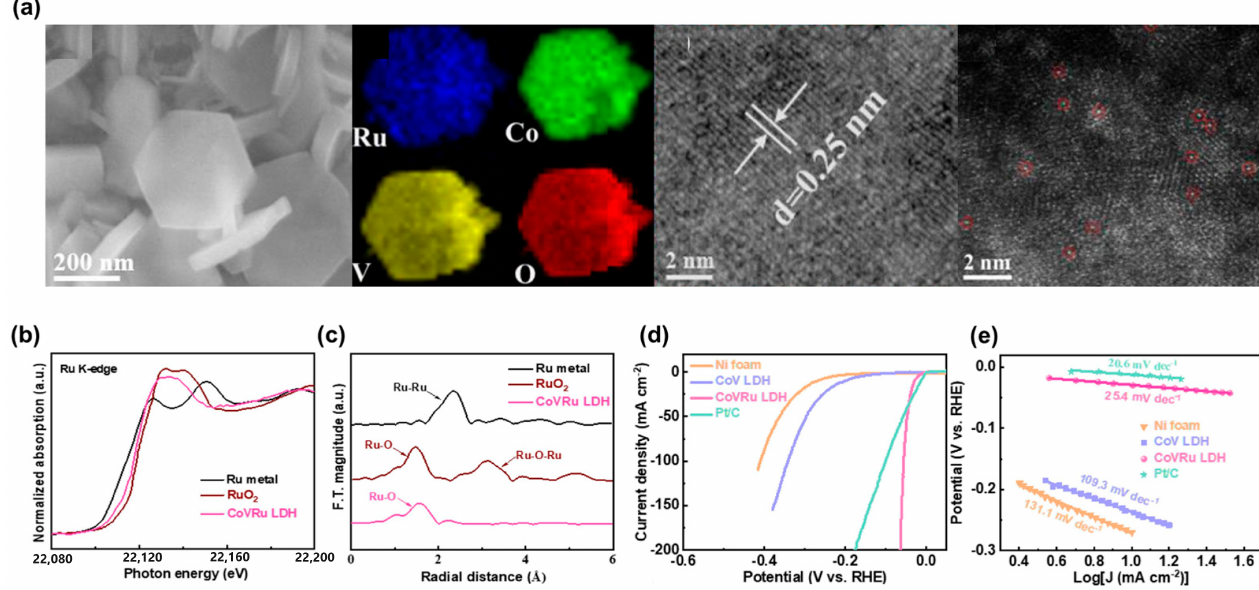
Figure 6. ( a ) SEM image (left) of hexagonal nanoplatelets of synthesized CoVRu LDH. STEM elemental mapping images with Ru, Co, V, and O. HR-TEM and HAADF-STEM images with d- spacing of 0.25 nm and atomically dispersed Ru sites, which are highlighted by red circles in CoVRu LDH. ( b ) Normalized XANES spectra and ( c ) Fourier-transformed EXAFS spectra of Ru K-edge for Ru metal, RuO 2 , and CoVRu LDH. ( d ) HER polarization curves and ( e ) calculated Tafel slope graph. Reprinted (adapted) from reference [139], copyright (2023) Elsevier